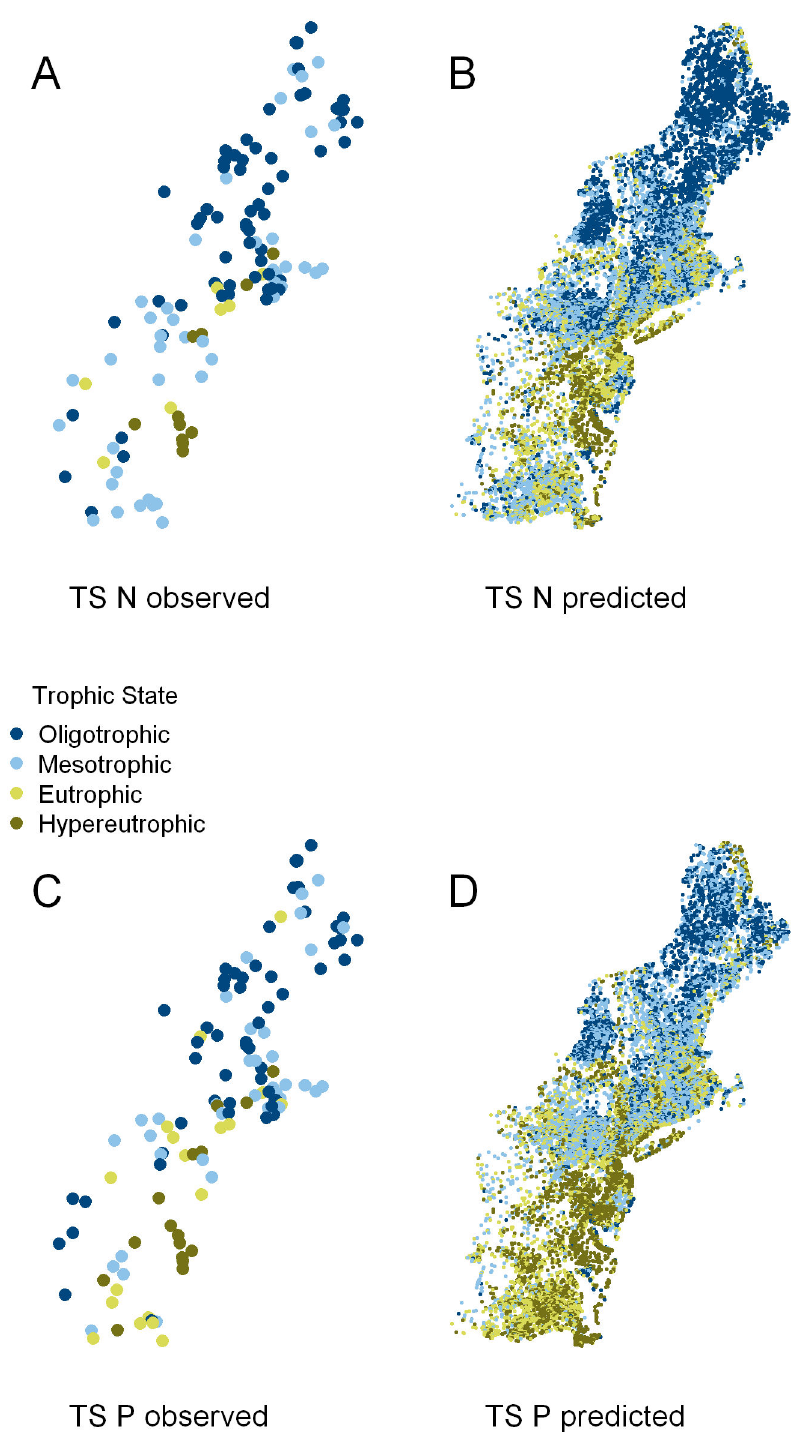
Figure 7. The geographical distribution of the Northeast lakes coded by trophic state. The National Lake Assessment Lake centroids with trophic state (TS) estimated from observed total (A) Nitrogen and (B) Phosphorus concentrations. Lakes with trophic state estimated from the Vollenweider adjusted predicted total (C) nitrogen and (D) phosphorus concentrations.